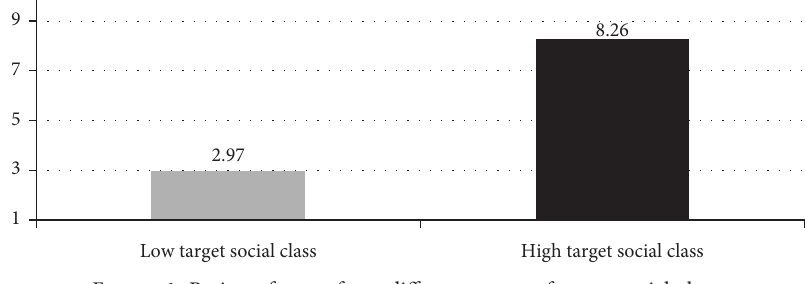
Figure 1: Rating of peers from different group of target social class. Table 1: Means and standard deviations of the number of points in a dictator game per condition in the study.